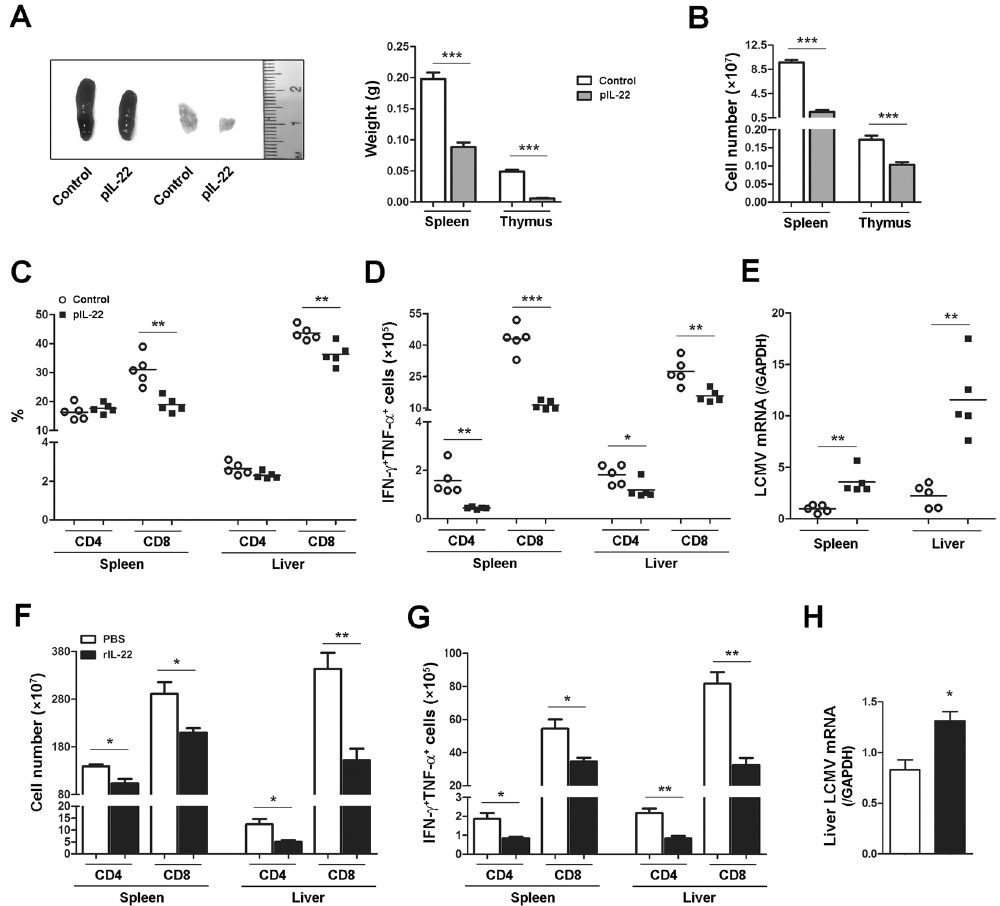
Figure 6. Over-expression of IL-22 dampens effector T cell response in acute viral infection. ( A to E ) B6 mice were infected with LCMV Arm (2 × 10 5 pfu/mouse) at day 0, and then hydrodynamically injected with pRK5- mIL-22 (pIL-22) or pRK5 (control) at 3 and 5 dpi. Mice were sacrificed at 7 dpi. ( A ) The spleen and thymus were weighed. ( B ) The number of leukocytes in the spleen and thymus was counted. ( C ) The percentage of CD4 + and CD8 + T cells in the spleen and liver were analyzed by flow cytometry. ( D ) The number of IFN- γ + TNF- α + CD4 and CD8 T cells in the spleen and liver was determined with flow cytometry. ( E ) Expression of viral mRNA was determined by qPCR. ( F to H ) B6 mice were infected with LCMV Arm and then i . p . injected with recombinant IL-22 protein (5 µ g/mouse) or PBS at 1, 3 and 5 dpi. Mice were sacrificed at 7 dpi. ( F ) Plots for the number of splenic or hepatic CD4 + and CD8 + T cells. ( G ) The number of IFN- γ + TNF- α + CD4 and CD8 T cells in the spleen and liver was analyzed by flow cytometry. ( H ) Expression of viral mRNA in the liver was determined by qPCR. Data are representative of two independent experiments. The results are expressed as the mean ± SEM ( n = 4–5). * p < 0.05; ** p < 0.01; *** p <